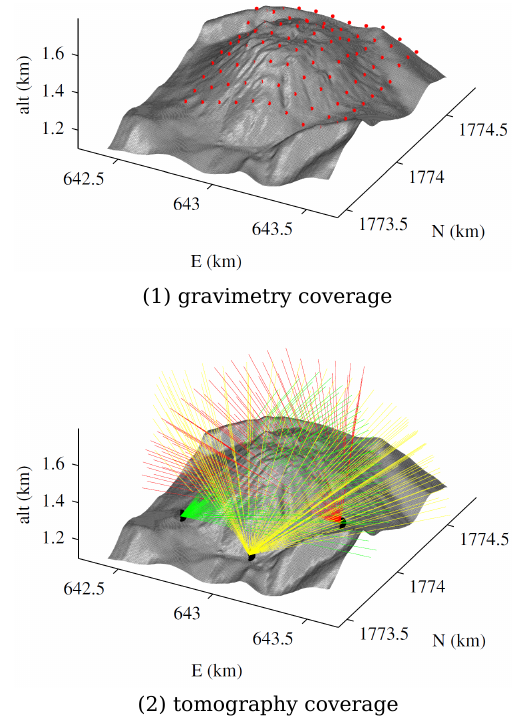
Figure 1. (1) The red dots represent the positions at which we sim- ulated gravimetry measurements on the Soufrière of Guadeloupe; (2) muon tomography data coverage. The lines represent the obser- vation axes of the muon telescope when located at Rocher Fendu (red), Ravine Sud (yellow) and Savane à Mulets